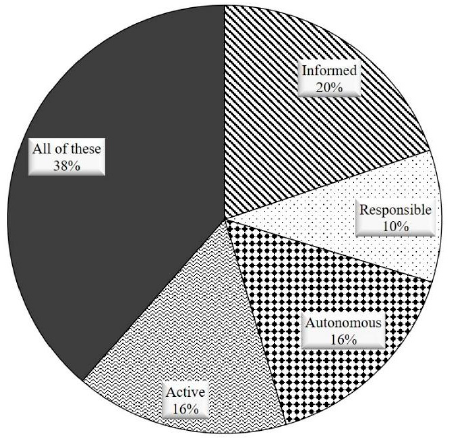
Figure 1. Empowerment definition percentages.